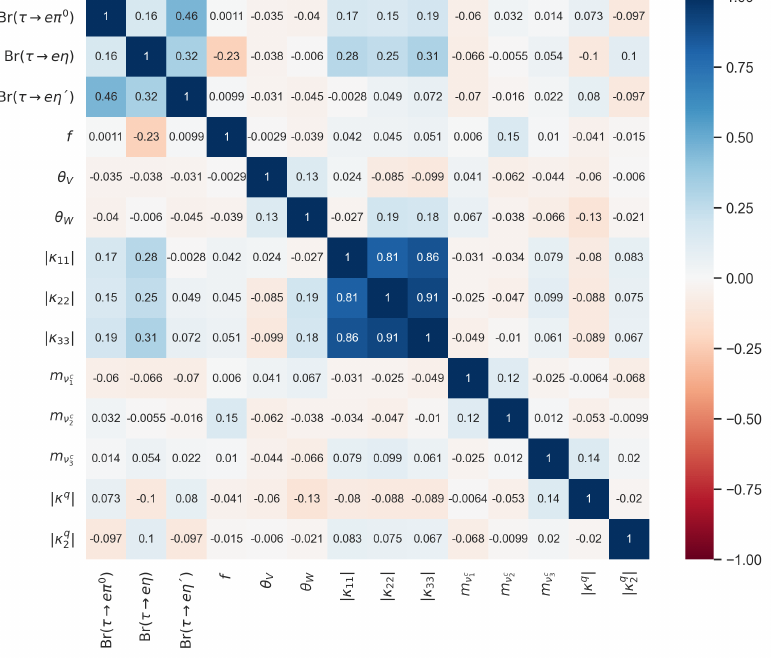
Figure 6 . Heat map showing little correlation among τ → eP decays and their free parameters (case without Majorana neutrinos).